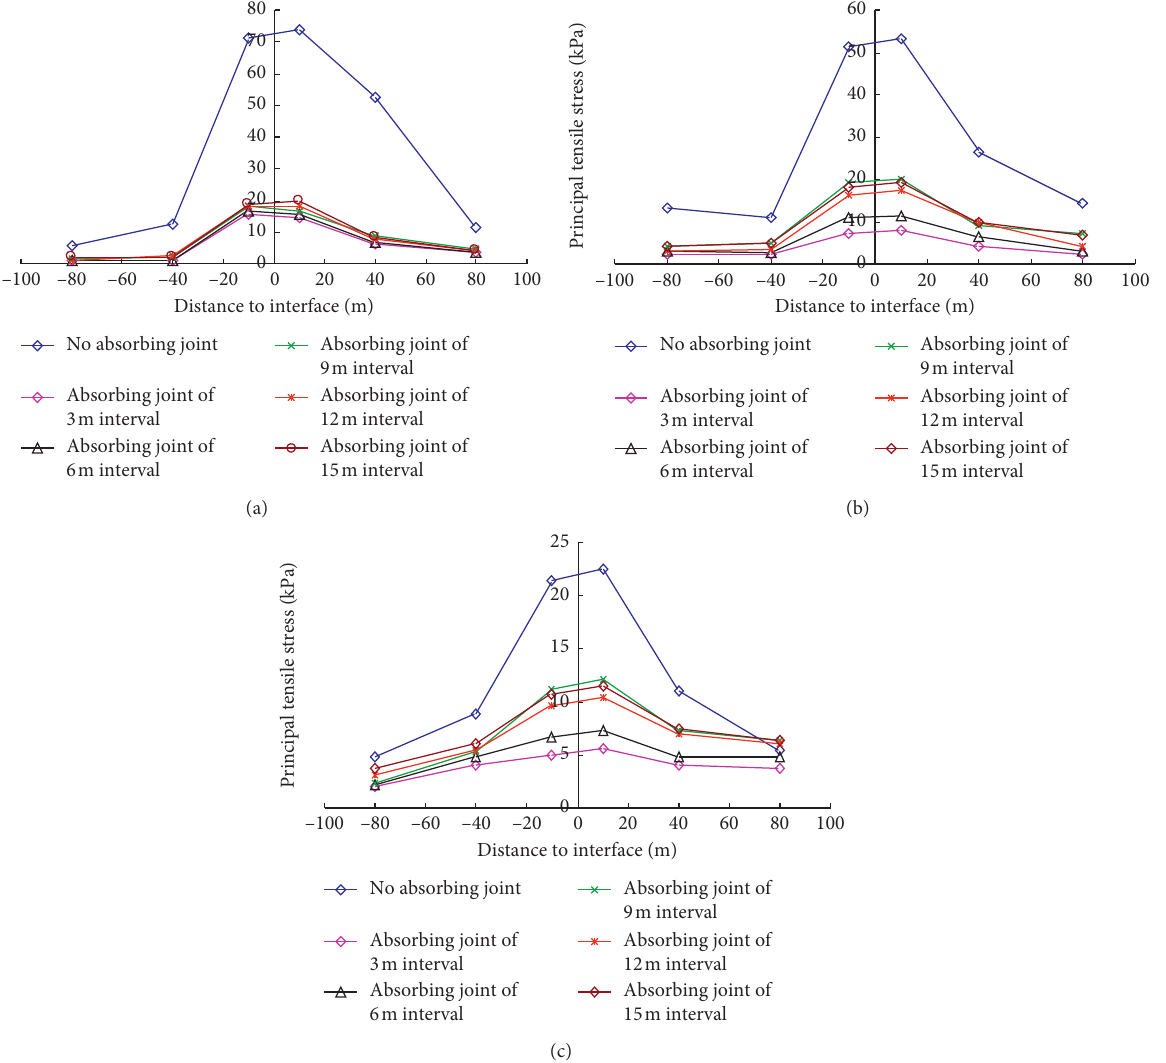
Figure 11: Principal tensile stresses of different parts of each monitoring section. (a) Vault of tunnel. (b) Side wall of tunnel. (c) Invert of tunnel.